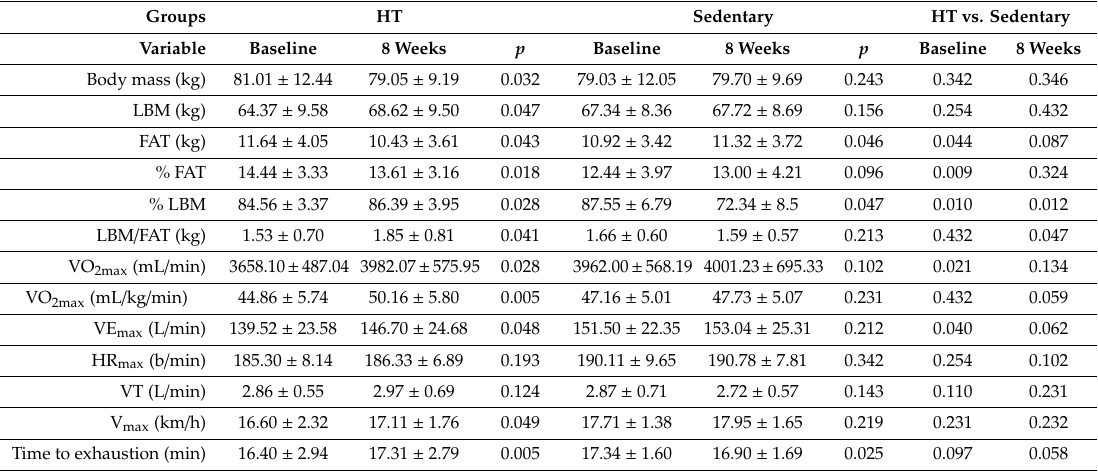
Table 1. Chosen anthropological and physiological parameters at the baseline and after 8-weeks of training.